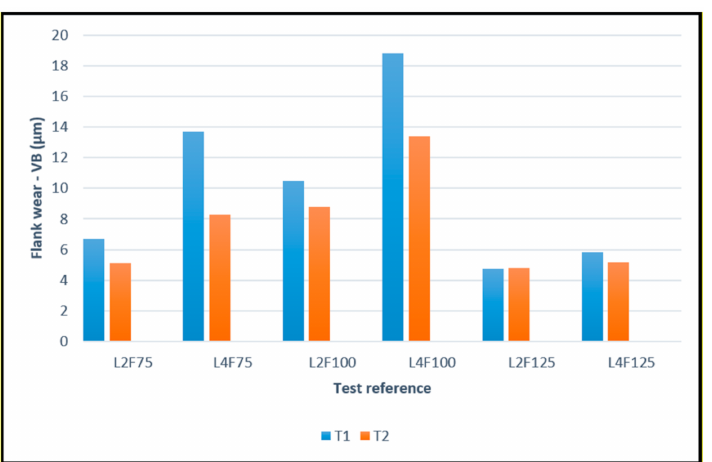
Figure 11. Average values of VB, measured in the clearance faces of T1 and T2 tools, for all the tested cutting